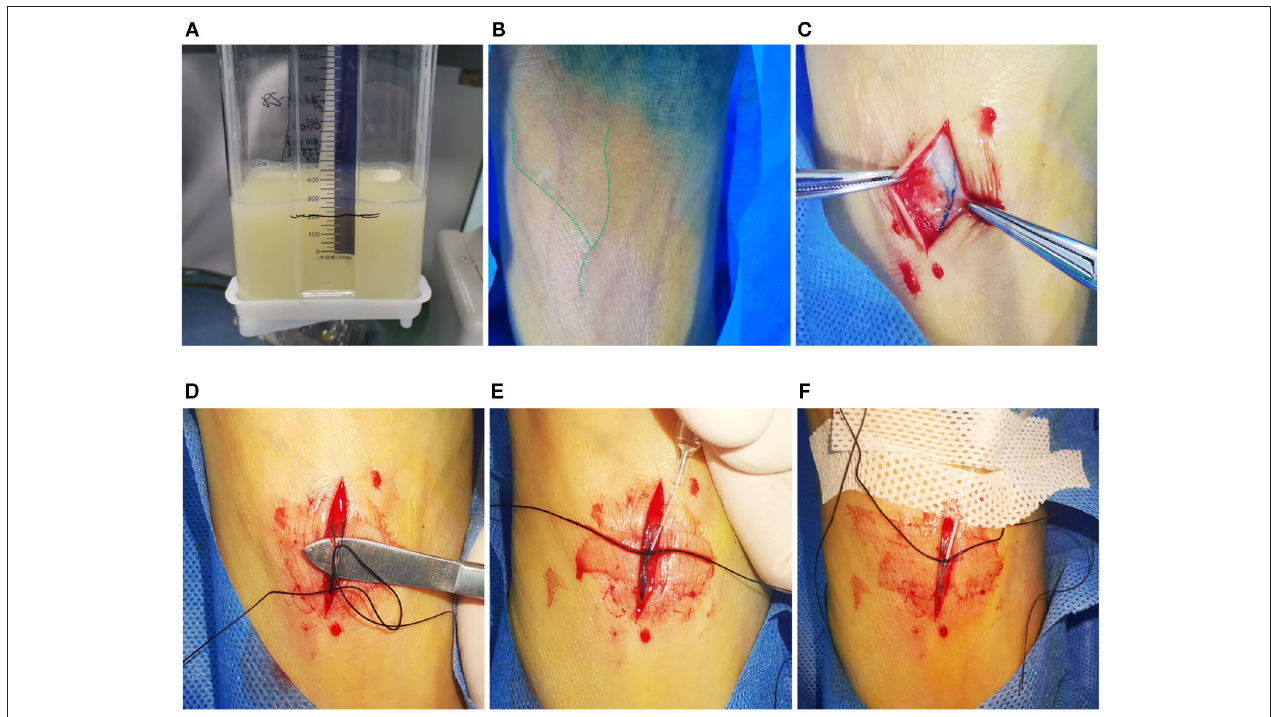
FIGURE 1 | Typical visual demonstration of chylothorax drainage and cannulation of pedal lymphatic vessel in TL procedure. (A) Typical visual demonstration of chylothorax drainage. (B) 20min after dye injection between interdigital spaces, superficial lymphatic vessels could be observed with tinted blue color (alongside the green dash line) on dorsal foot. (C) After incision, subcutaneous lymphatic vessels can be clearly found with deep blue color. (D) Meticulous separation of the target lymphatic vessels. (E) Manual puncture of the lymphatic vessel by using a 26-G intravenous needle. (F) After fixation of the trocar by suture and sterile tape, the ethiodized oil can be injected afterwards.